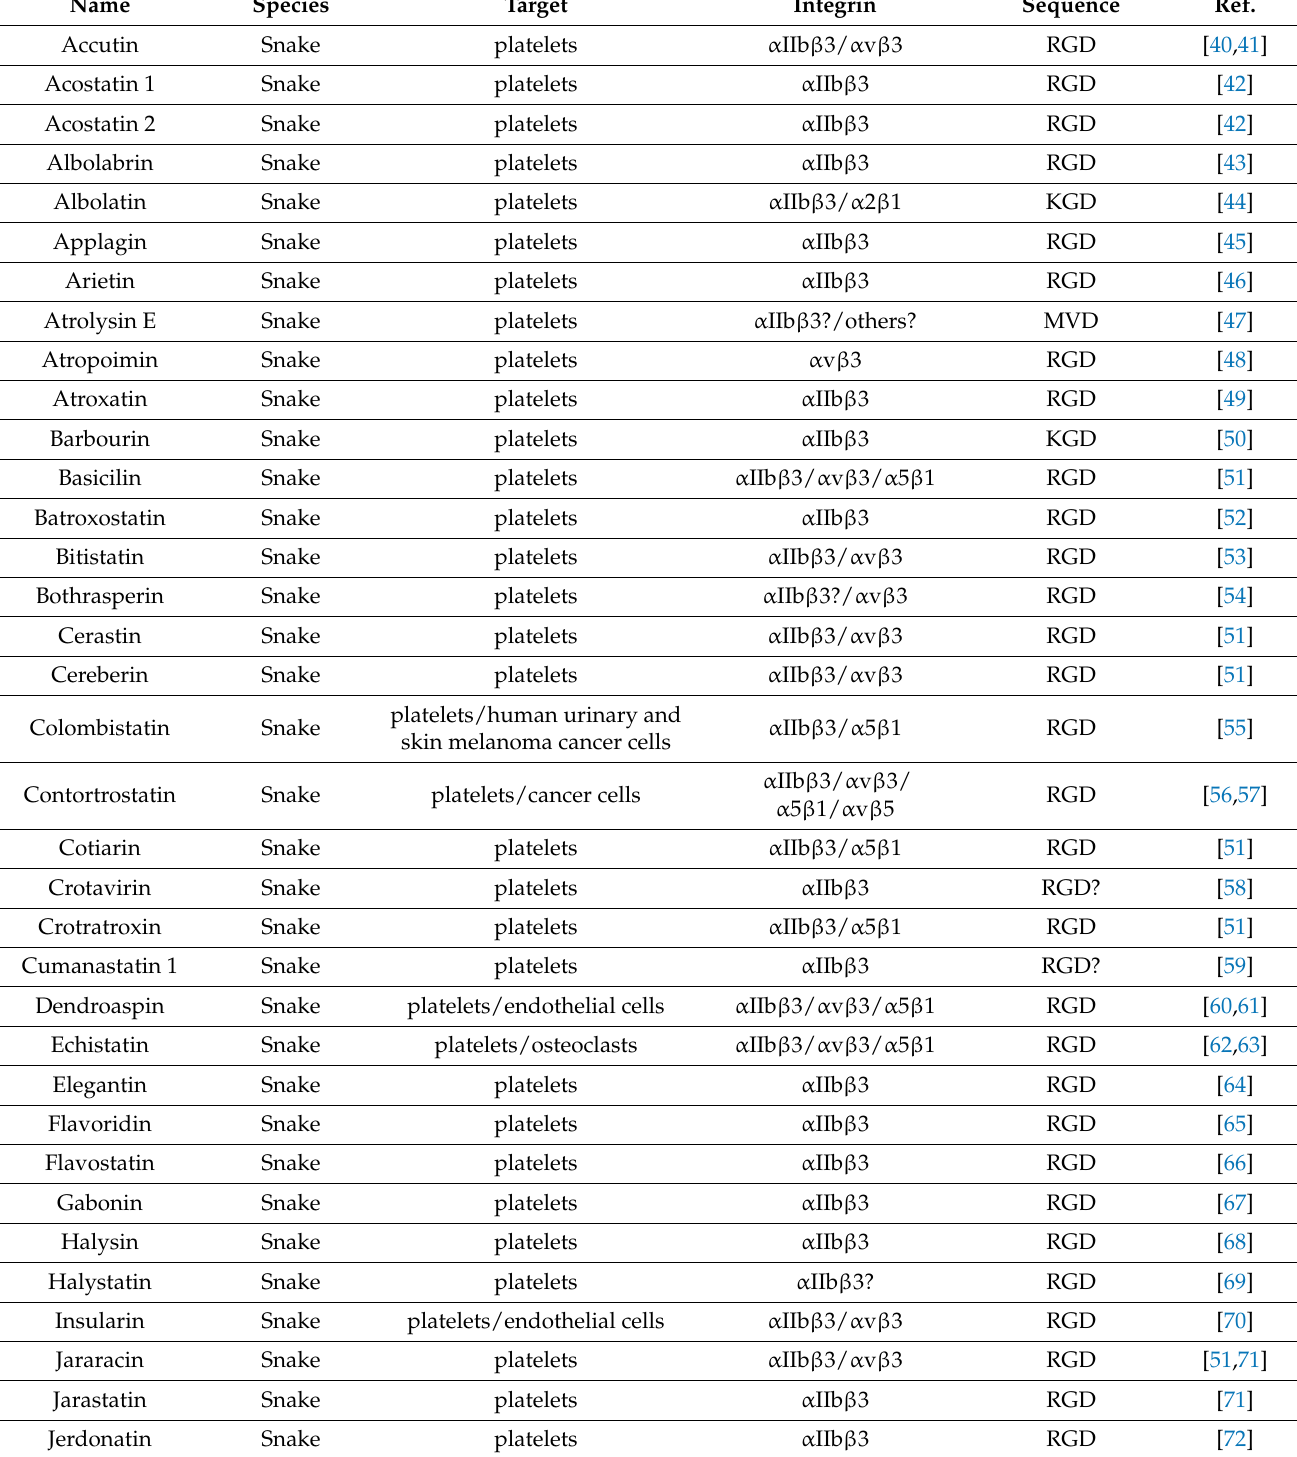
Table 1. Overview of the disintegrins in different species that target the α IIb β 3